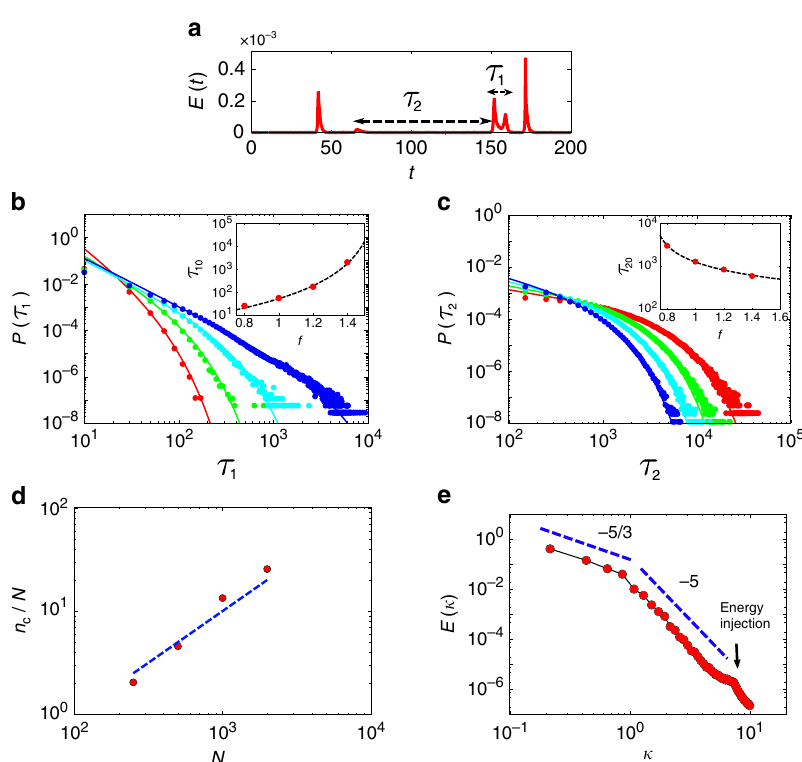
Fig. 4 Statistics of yielding, emergence of viscoelasticity and plastic turbulence. a Within the intermittent phase, bursts of activity having duration τ 1 occur amidst quiescent states having duration τ 2 , for f = 1.0. b , c The distributions of the periods of intermittent bursts [shown in b ] and quiescence [shown in c ] can be fi t to a power law with an exponential cut-off, P ð τ functions shown as lines. Data shown for f = 0.8 (red), 1.0 (green), 1.2 (cyan) and 1.4 (blue); the exponents vary with f and are measured to be α = 2.97, 2.30, 2.04 and 2.07 in b , β = 0.57, 0.57, 0.72 and 0.94 in ( c ). The inset shows the variation of the cut-offs τ 10 and τ 20 with f . We note that the cut-off for τ 1 , moves to larger times as f → f * ( τ p ) from below, whereas τ 20 increases as f → f c ( τ p ) from above, giving rise to a power-law behaviour at the two limits. d The intermittent yielding events involve the non-af fi ne displacement of a fi nite fraction of particles, as seen in this plot of n c , the number of particles that show a non-af fi ne displacement within a time window Δ t = 10 4 , versus total particle number N , where the dashed line has slope 1. e The scale-free intermittency close to the phase boundary f * ( τ p ), is associated with plastic turbulence as seen in the spectrum of the energy density E ( k ) that shows an inverse cascade from an injection scale, shown by the arrow. Data shown for f = 1.6, τ p = 10 4 . The crossover from a steep spectrum k − 5 to the Kolmogorov spectrum k − 5/3 at lower k , is set by the scale of the